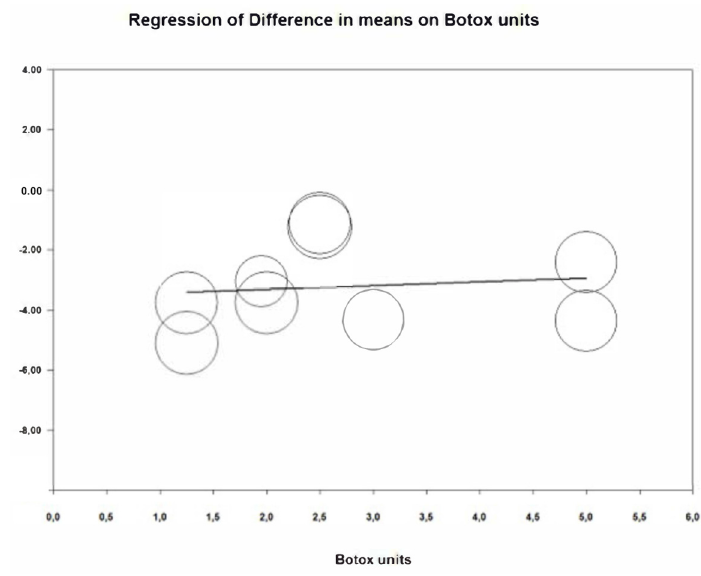
Figure 2. Reduction in gummy smile at two weeks.